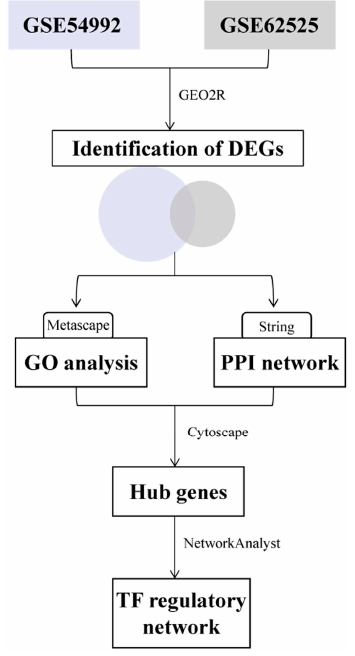
Figure 1. The flow diagram of this study.